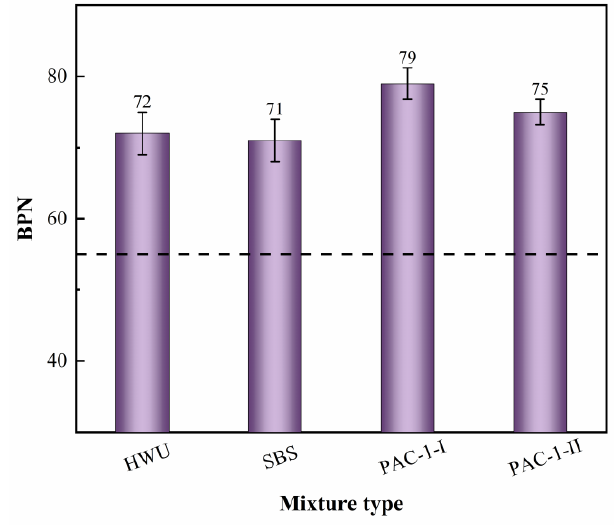
Figure 10. Pendulum test results of the mixtures.